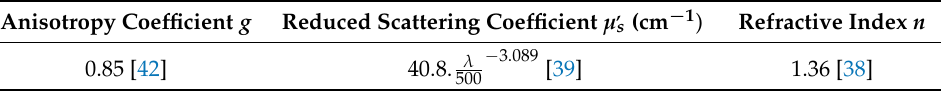
Table 1. Anisotropy, reduced scattering coefficients, and refractive index used in the Monte Carlo